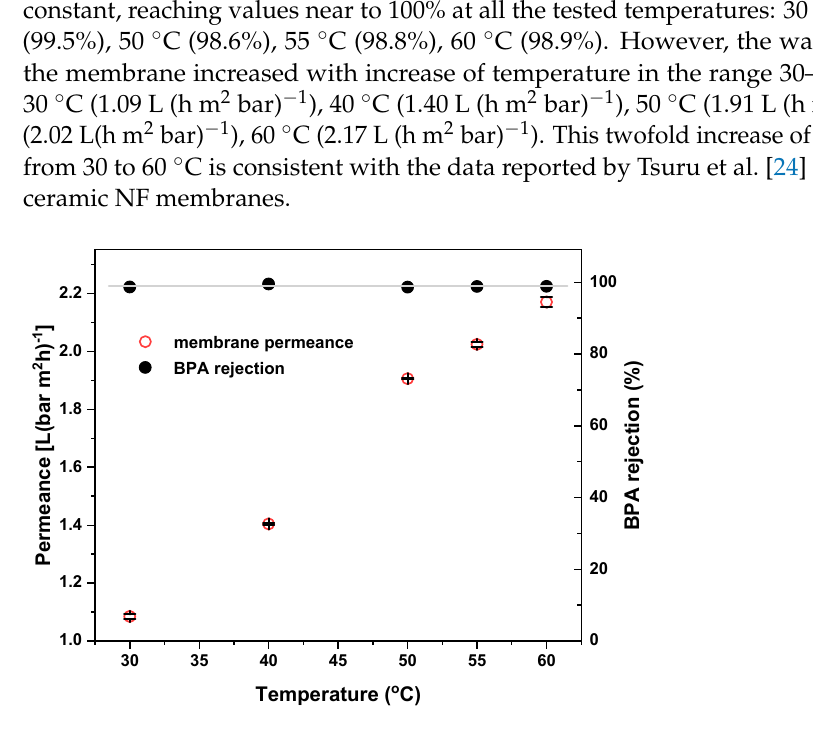
Figure 3. Impact of temperature on water permeance and BPA rejection for the Al 2 O 3 -doped silica NF membrane used in this study. Black bars indicate the error for the permeance values.